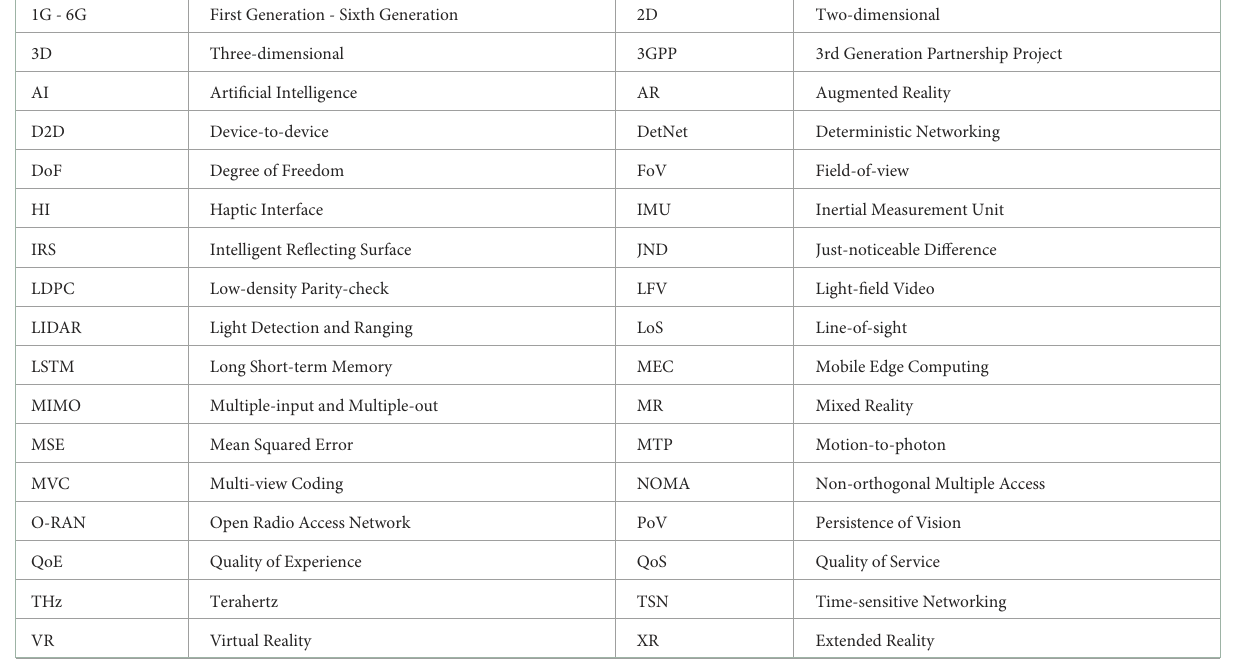
TABLE 1 List of main